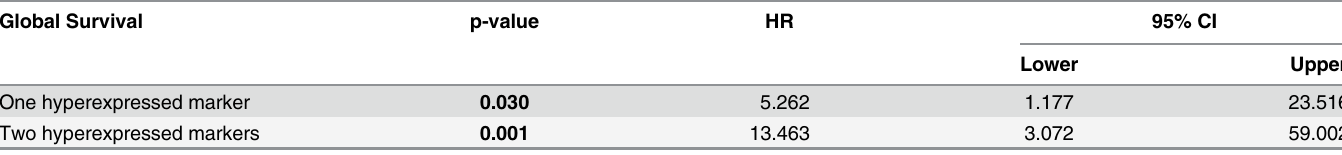
Table 7. Cox regression analysis using the combined risk score of ITGAV and ITGA6 overexpression as an independent variable and GS as a dependent variable. Global Survival